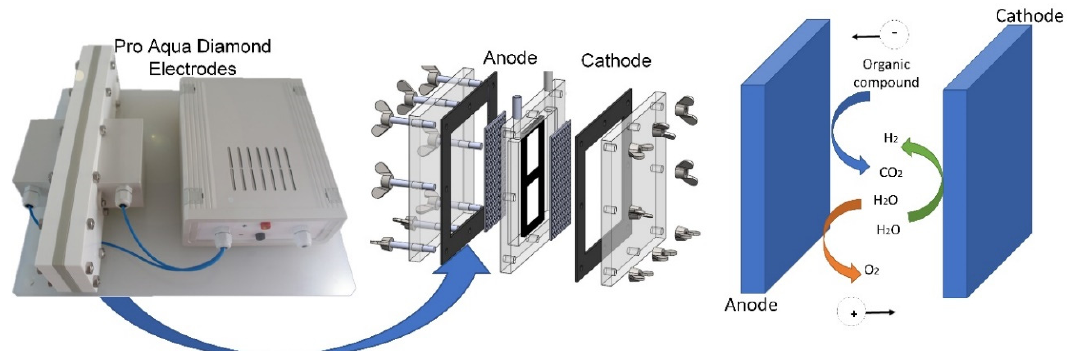
Figure 1. Pro Aqua diamond electrodes and electro-oxidation chamber scheme.